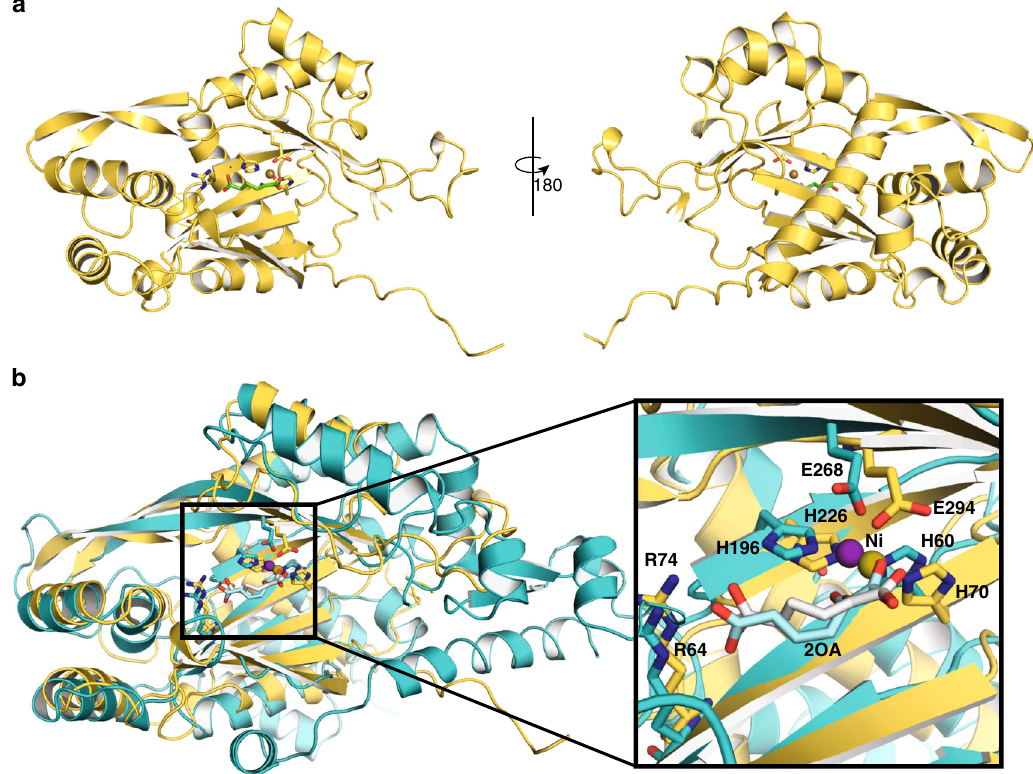
Fig. 2 Structural comparison of FLO7 and HglS. a FLO7 crystal structure displayed as cartoon sheets and helices. Metal-coordinating and substrate- binding residues are shown as sticks, while the 2-oxoadipate substrate is shown as green sticks. The nickel bound within the active site is shown as a tan sphere. b Overlay of HglS (teal) and FLO7 (yellow) structures showing metal-coordinating residues, substrate-binding residues, the active site metal, and the 2-oxoadipate substrate. Right inset: HglS (teal) and FLO7 (yellow) active sites displaying conserved residues and substrate-binding mode. The 2OA substrates are colored light blue (HglS) and white (FLO7), and the active site bound nickel shown as spheres and colored blue (HglS) and olive